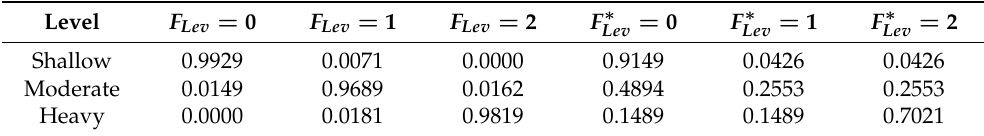
Figure 7. Frequency statistical histogram and normal distribution fitting curves of fog density levels of the 36 training images. Different color means different fog density level. Table 1. The accuracy of fog density level estimation in the training stage and the test (marked with “*”)